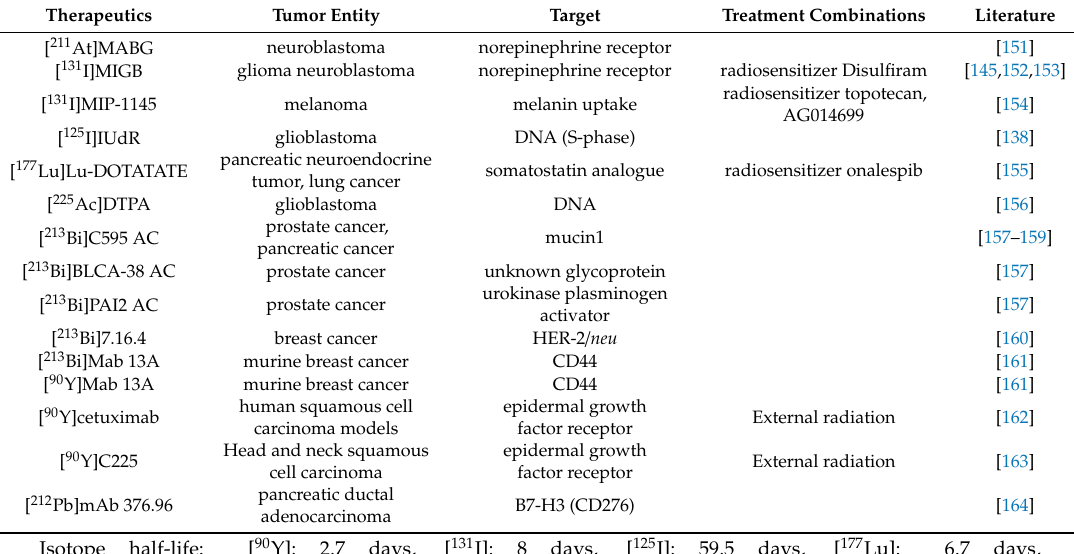
Table 3. Examples for radiopharmaceuticals that have been used on 3D models of various tumor entities and partly in combination with radiosensitizers or external